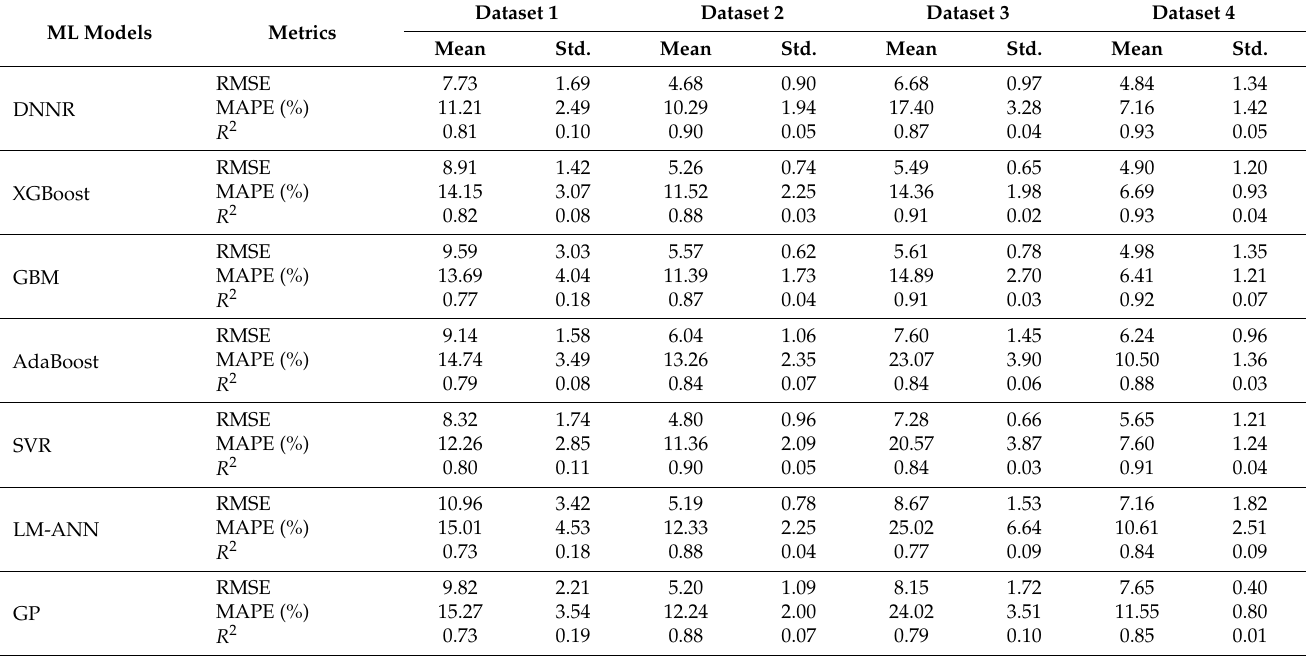
Table A1. Detailed statistical performance of the ML